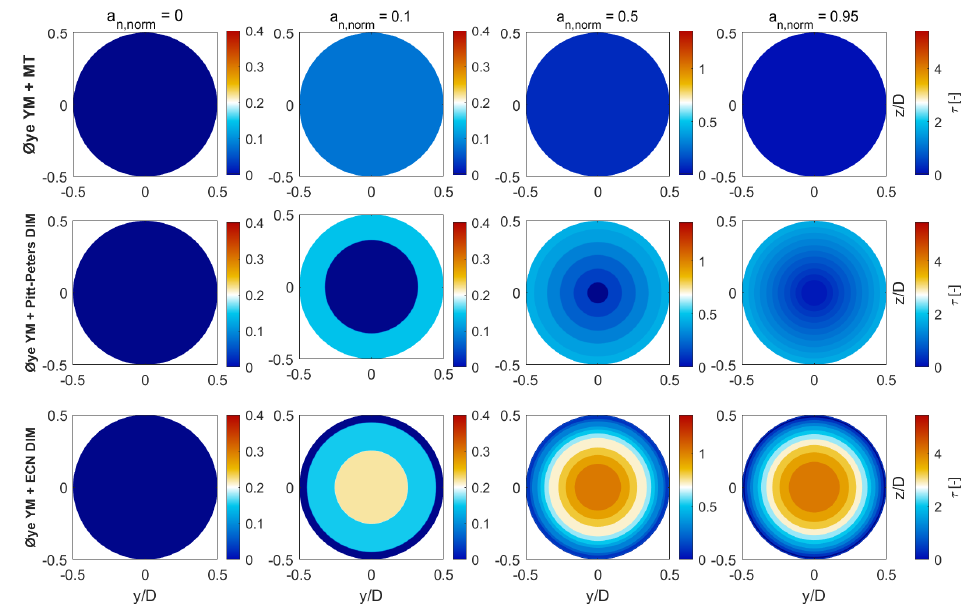
Figure 16. Varying τ at the a n , norm of center = 0.0, 0.1, 0.5, 0.95 from different models when step ∆ C Φ y = 30 deg. T = +0.1,